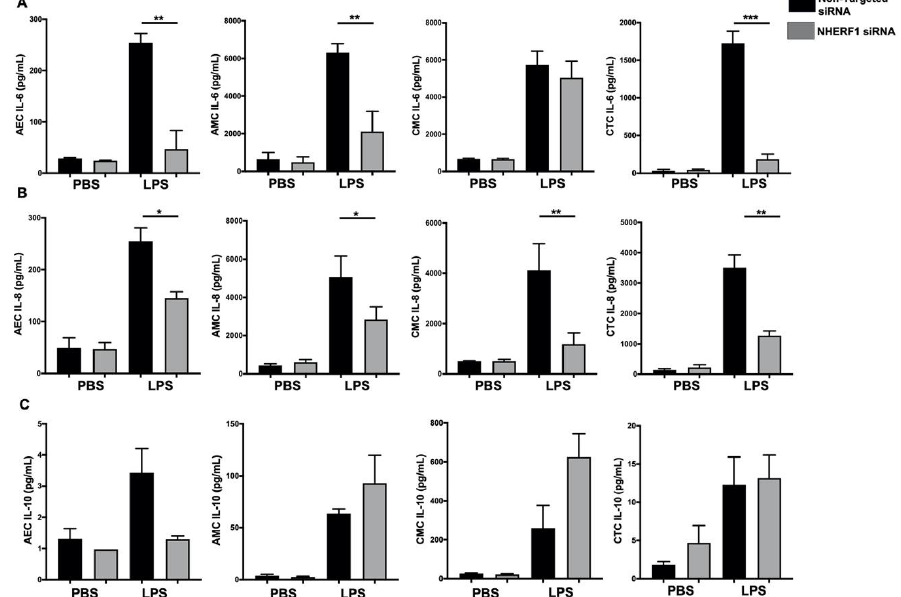
Figure 7. Effect of NHERF1 in production of inflammatory cytokines from primary cells treated by LPS. Control nontargeted siRNA and NHERF1 siRNA knockdown cells were treated with LPS for 48 h, and a multiplex assay was performed to estimate ( A ) IL-6, ( B ) IL-8, and ( C ) IL-10 levels in different primary cell supernatants. Data is mean ± SEM from three experiments. Statistical significance was determined by unpaired student t -test considering scrambled RNA as a control. * p < 0.05, ** p < 0.01, and *** p < 0.001 .